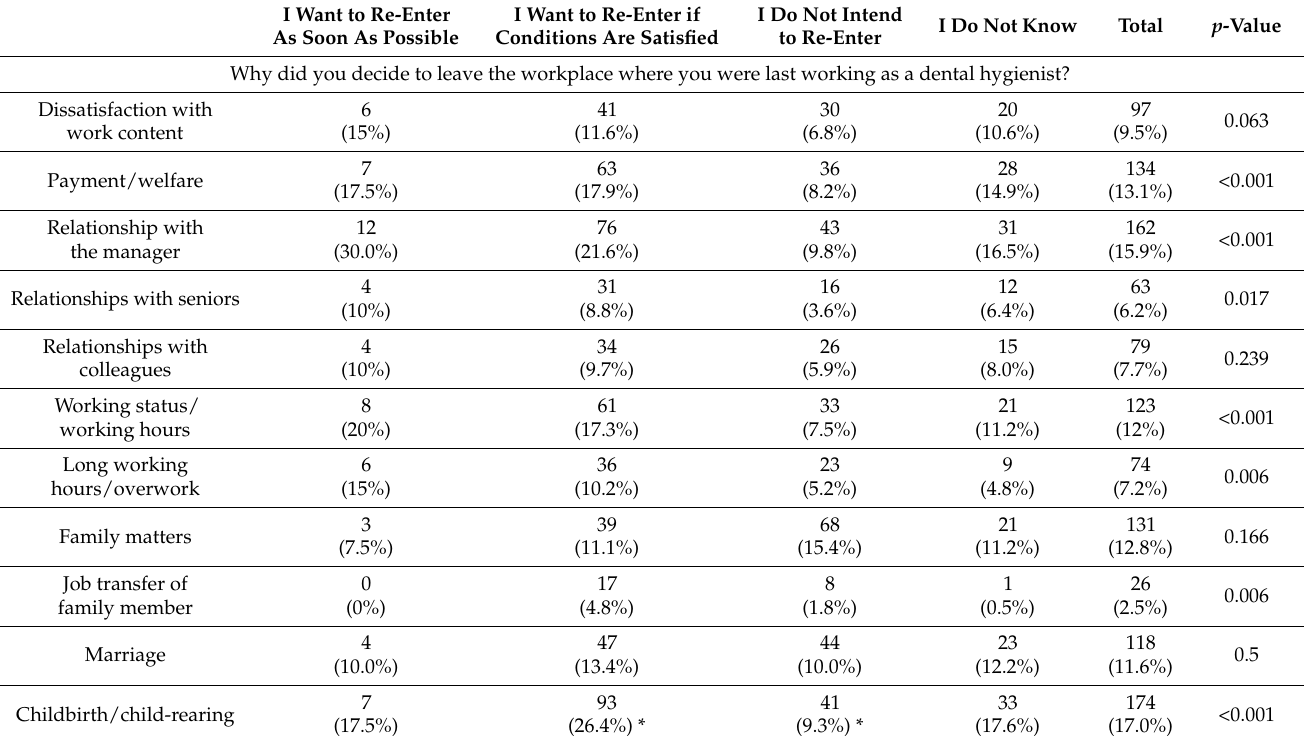
Table 2. Characteristics of the participants involved in this study by classification of willingness to